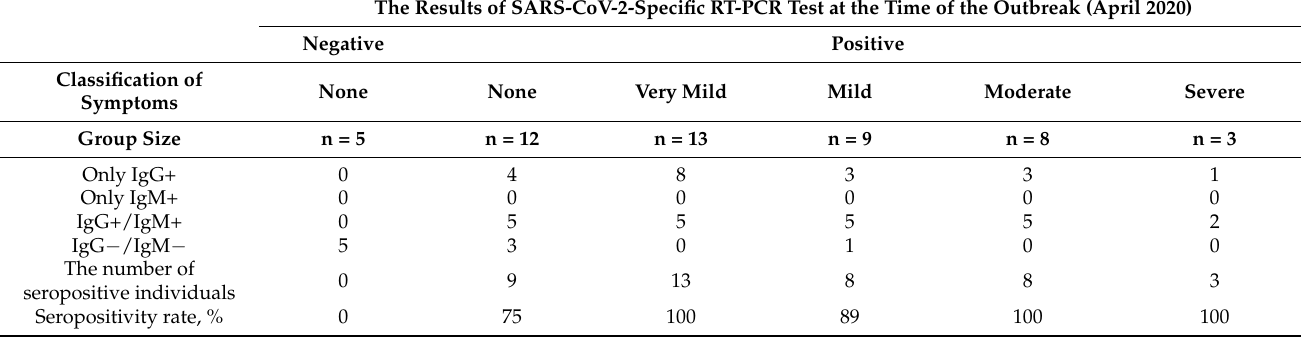
Table 2. Summarized results of the first serologic testing 2 months after the outbreak (17 June 2020). The Results of SARS-CoV-2-Specific RT-PCR Test at the Time of the Outbreak (April